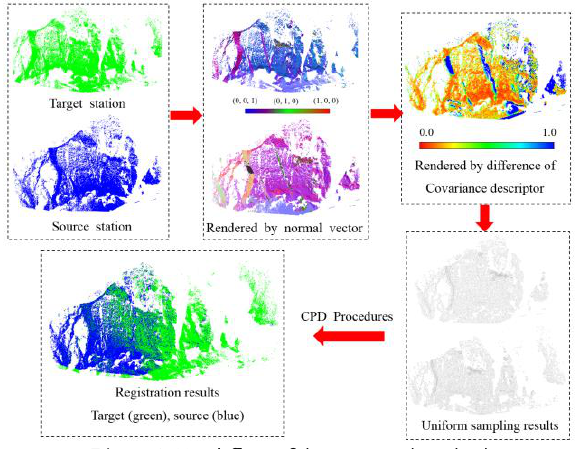
Figure 1. Workflow of the proposed